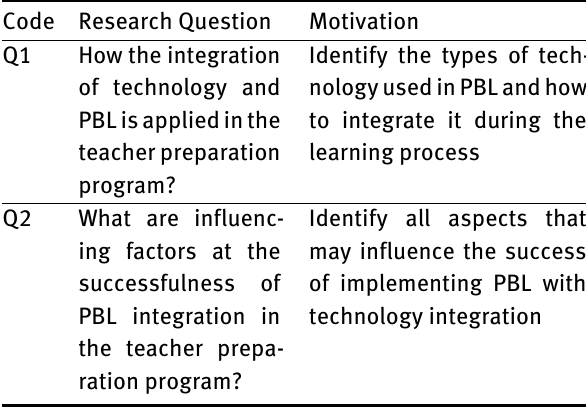
Table 1: Research questions and motivation on current